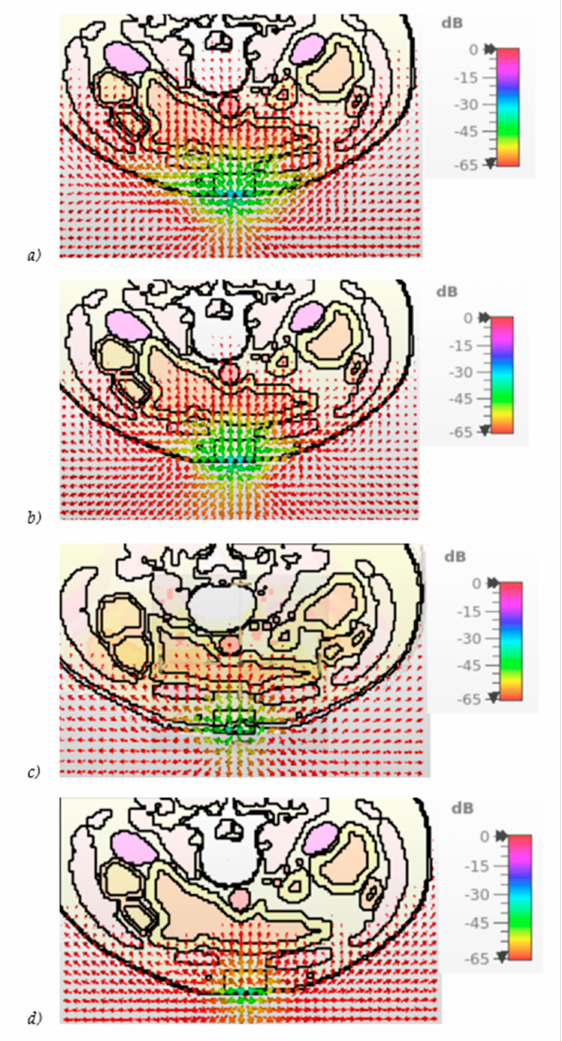
Figure 12. Power flows in the vertical cross-cuts of the voxel models at ( a ) 2.45 GHz, ( b ) 3.1 GHz, ( c ) 4 GHz, ( d ) 5.8 GHz, for the dB range − 65–0